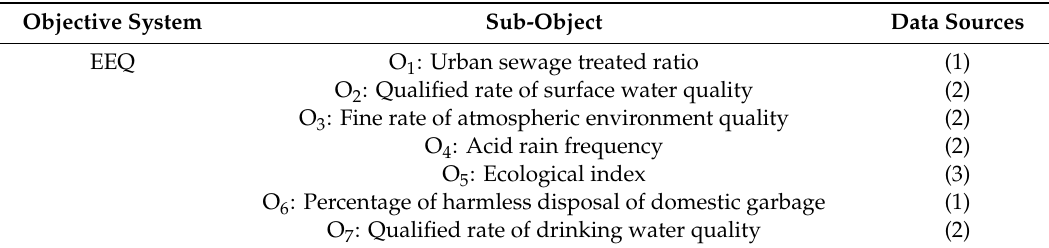
Table 2. The index system of